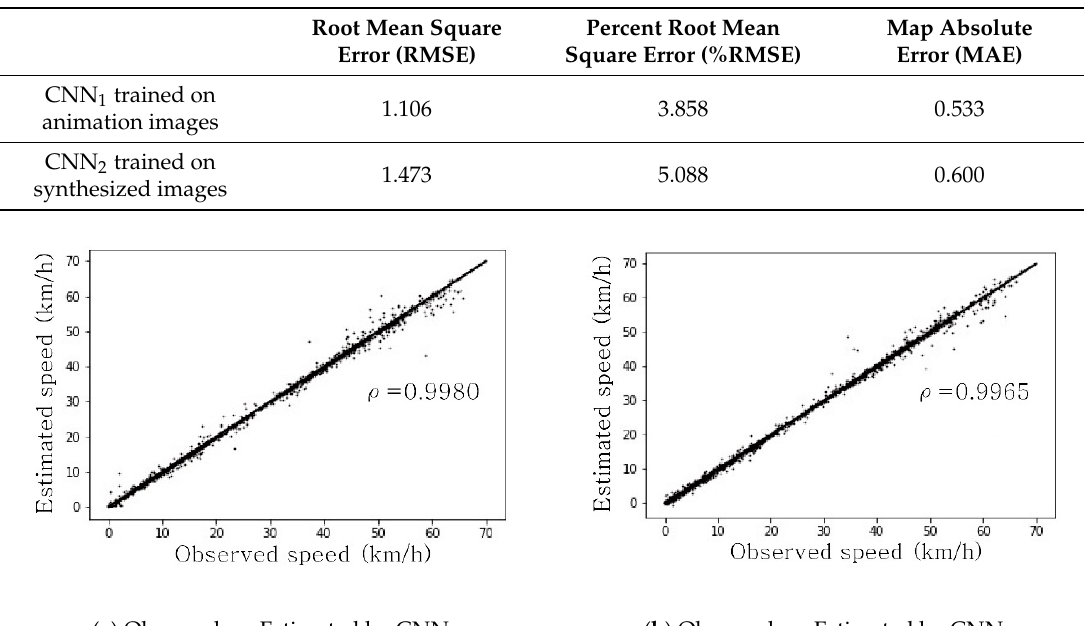
Table 1. The test results of two CNNs trained using synthetic images.